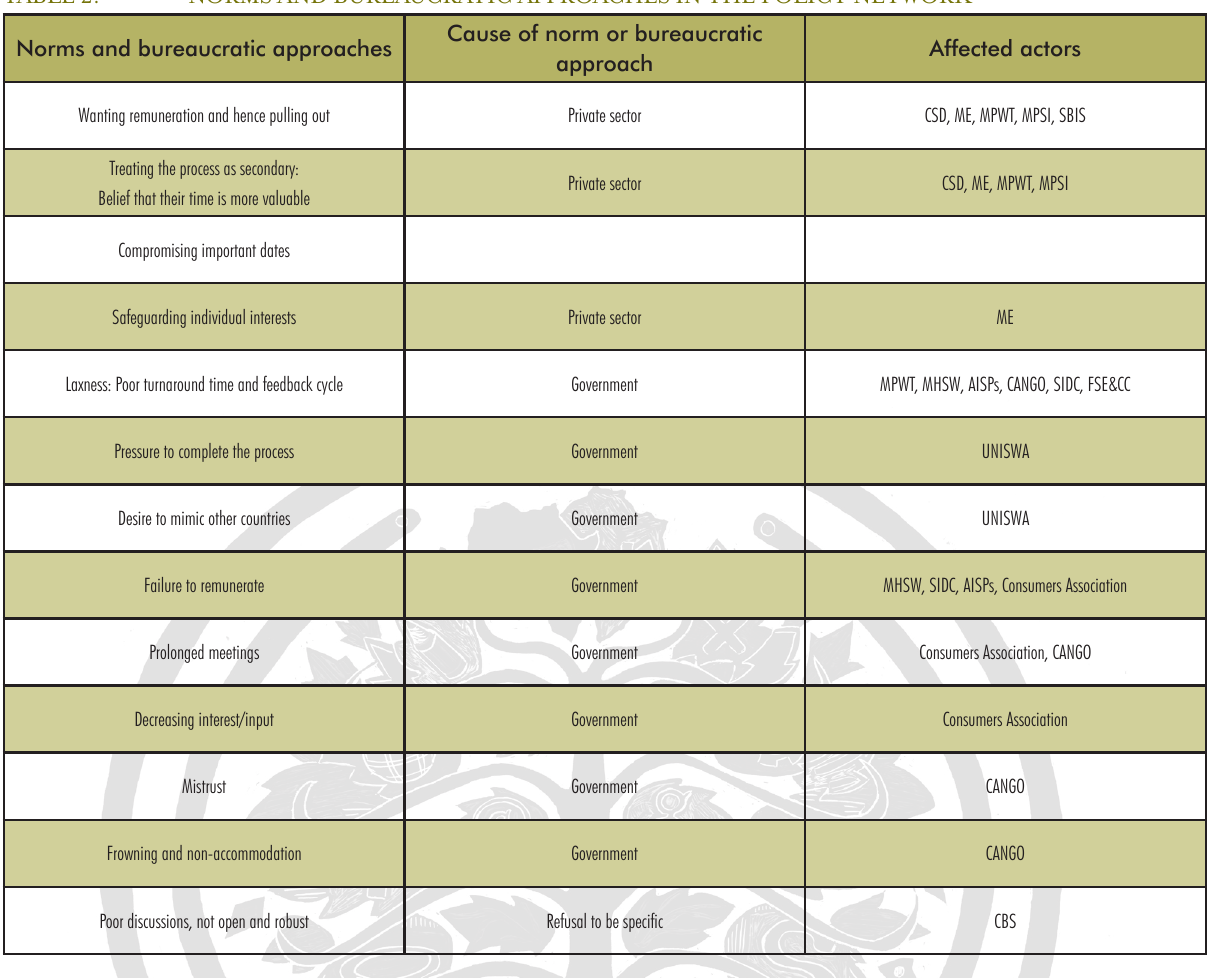
TABLE 2: NORMS AND BUREAUCRATIC APPROACHES IN THE POLICY NETWORK Norms and bureaucratic approaches